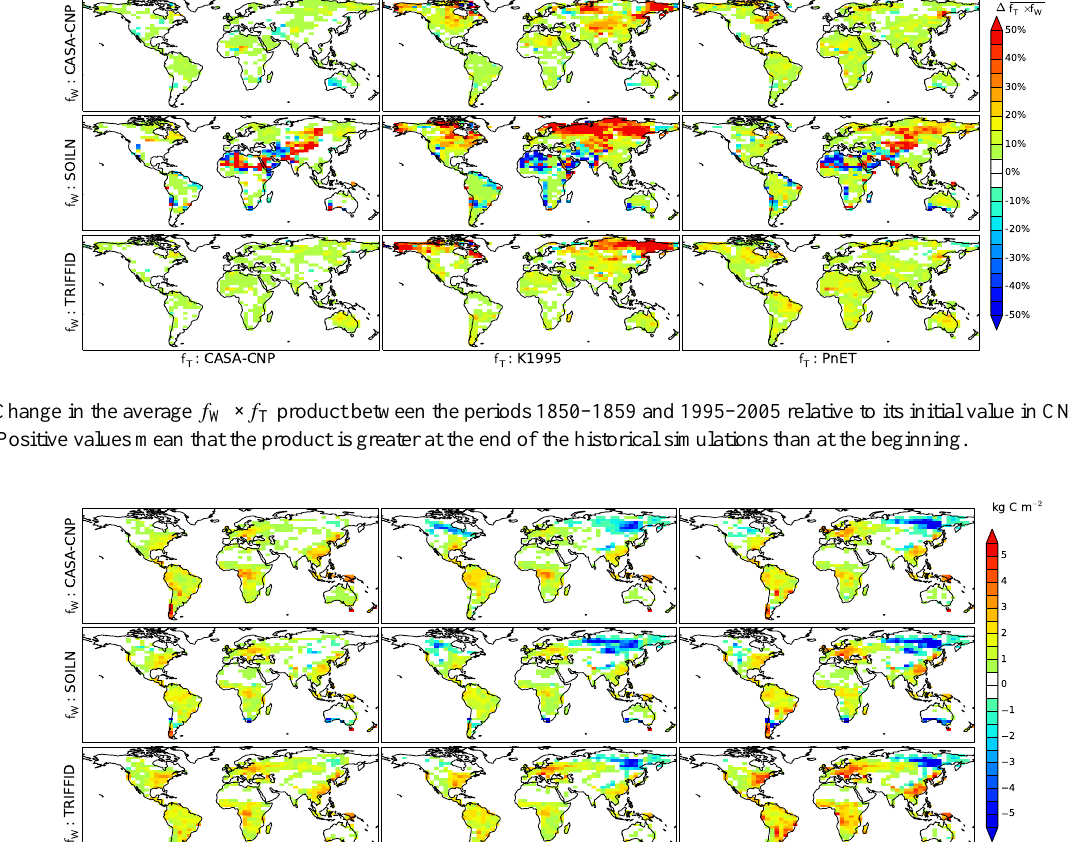
a large region of negative NEA (i.e. a net source of CO 2 ) is simulated in the northern latitudes of eastern Eurasia.